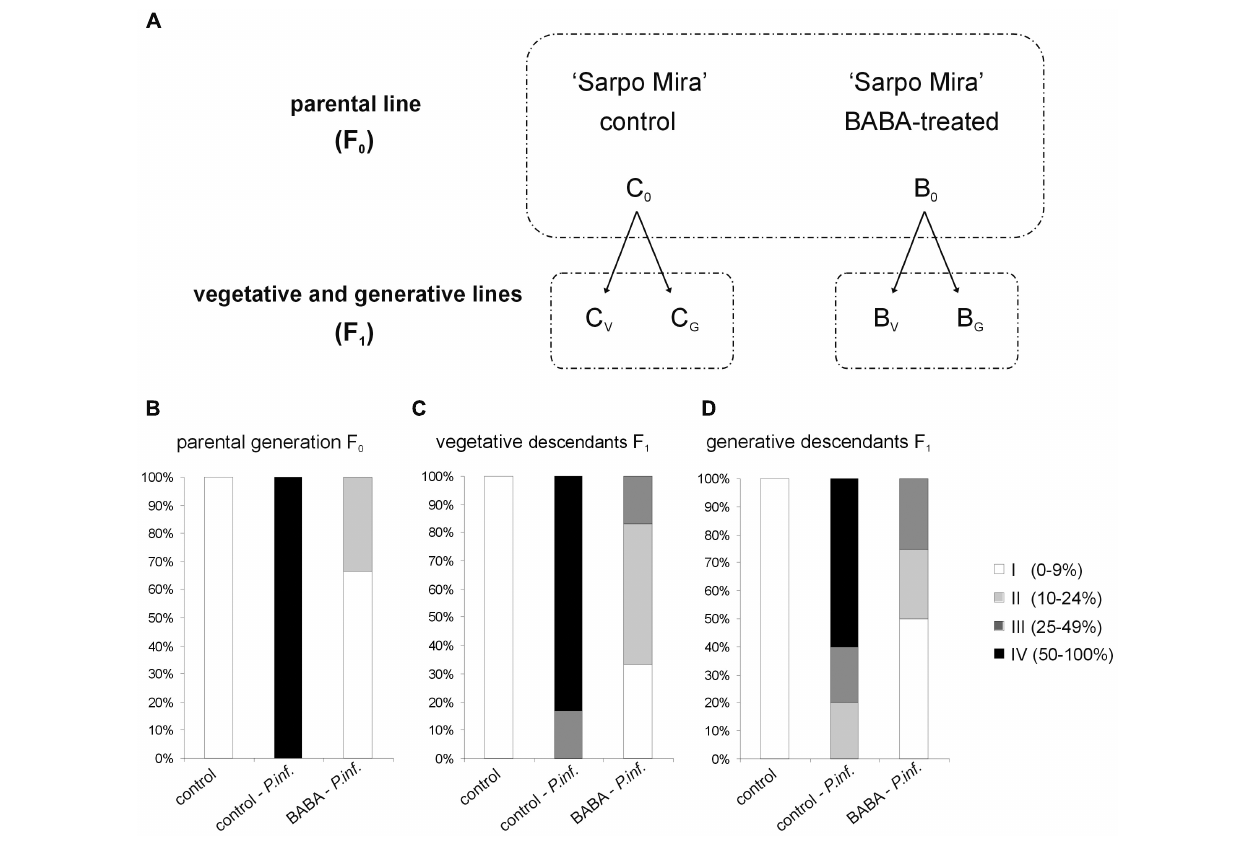
FIGURE 1 | Intergenerational resistance in potato progeny unprimed and BABA-primed to P. infestans . Schematic representation of the experimental design (A) ; the parental line of “Sarpo Mira” potato genotype (F 0 ) was treated once with 5 mM BABA (B 0 ). The progeny (F 1 ) grown from tubers or seeds were not again treated with BABA, but only inoculated with P. infestans - at the stage of 10 compound leaves. Abbreviations mean: the parental F 0 line BABA-primed – B 0 , the offspring of primed plants of the vegetative F 1 line – B V , and the generative F 1 line – B G . Three days after BABA-exposure or water treatment (C 0 ) potato leaves were challenged with P. infestans and disease development was assayed at day 5 after P. infestans inoculation (dpi). BABA-induced resistance against P. infestans in the parental (F 0 ) line (B) , intergenerational resistance in the vegetative F 1 progeny (C) , and in the generative F 1 progeny (D) . Disease index is based on a 1–4 point scale, which represents the percentage of leaf area covered by late blight symptoms. Values represent means of at least three independent experiments, each with at least three biological replicates. Asterisks indicate values that differ significantly from unprimed (water treated) or unprimed and P. infestans inoculated potato leaves at P < 0.05 ( ∗ ),